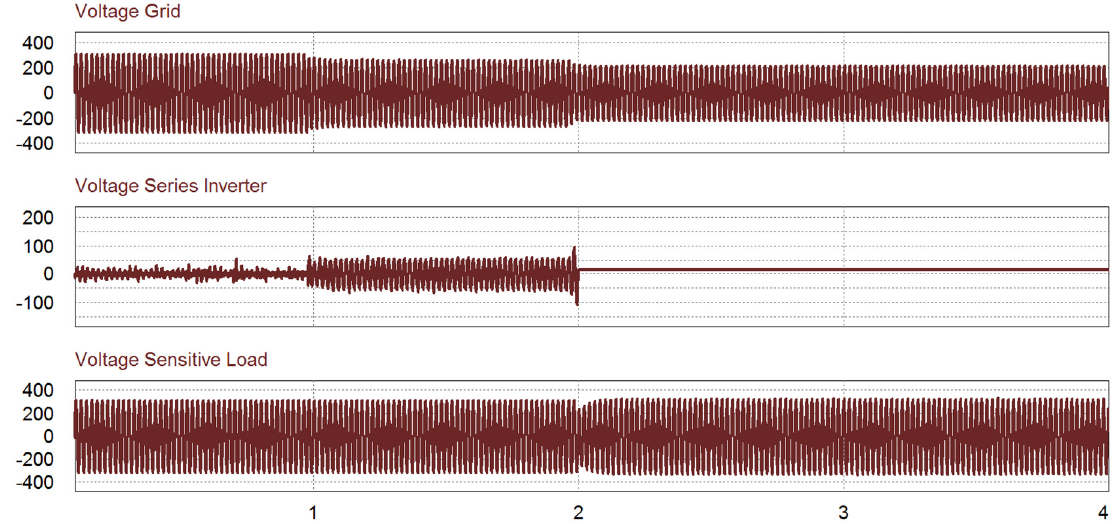
Figure 13. Simulation results of undervoltage case: ( top ) Grid voltage; ( middle ) series inverter voltage; ( bottom ) sensitive load voltage.